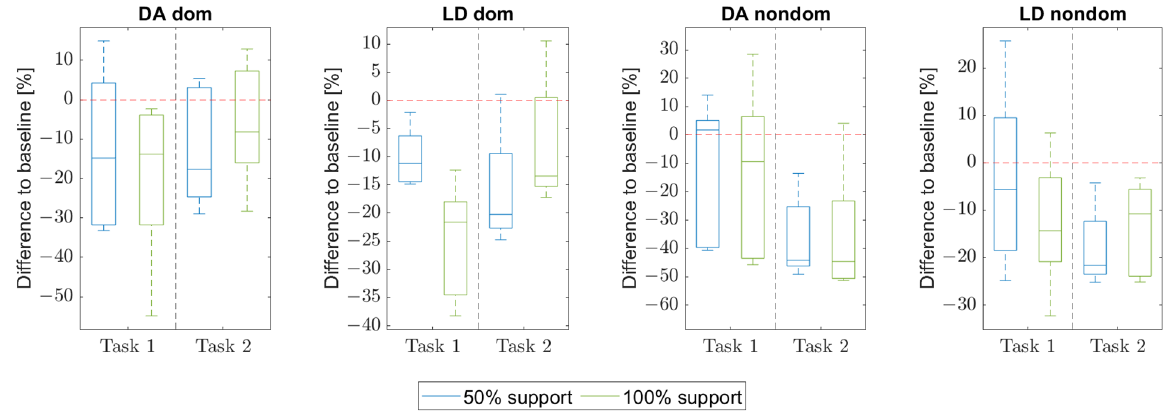
Figure 11. Differences in the mean EMGs of DAs and LDs under conditions S50 and S100 compared to S0 during arm lifting in both